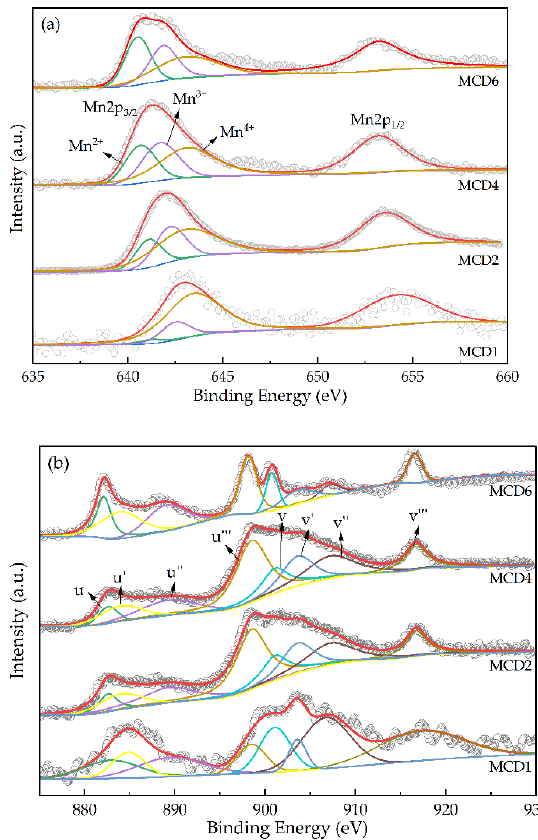
Figure 3. XPS spectra of the catalysts over the spectral regions: ( a ) Mn 2p; ( b ) Ce